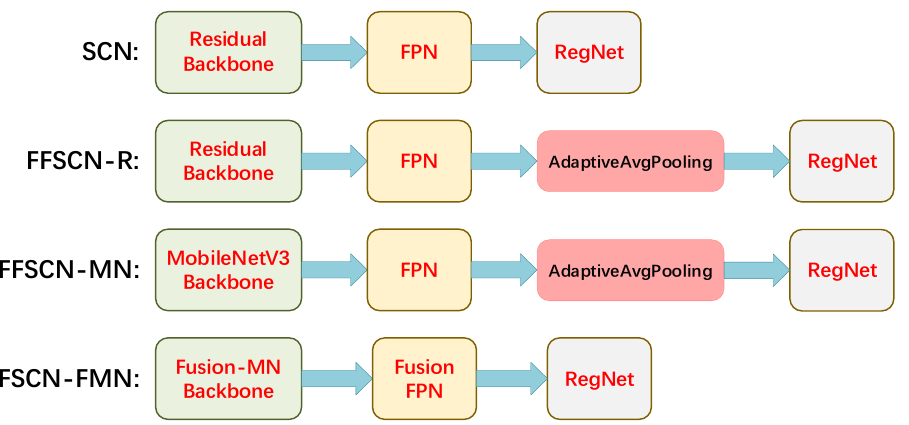
Figure 1. The architecture comparison of the FFSCN and SCN models.